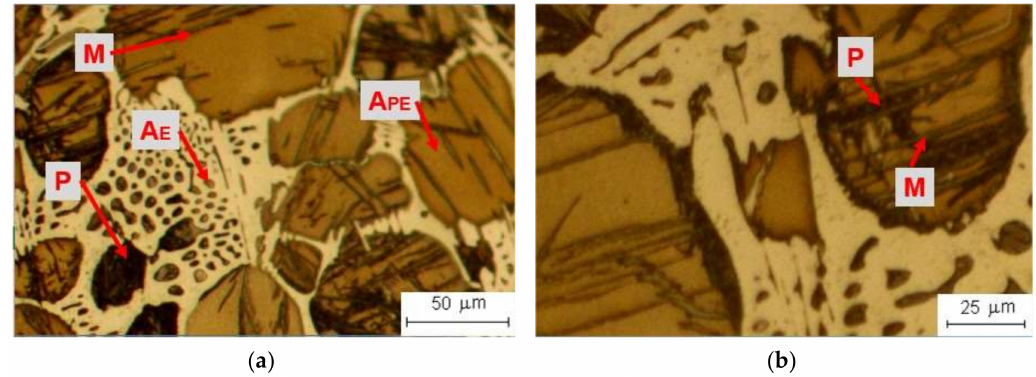
Figure 11. Picral reagent: ( a ) general view at 200 × ; ( b ) detail at 500 × .